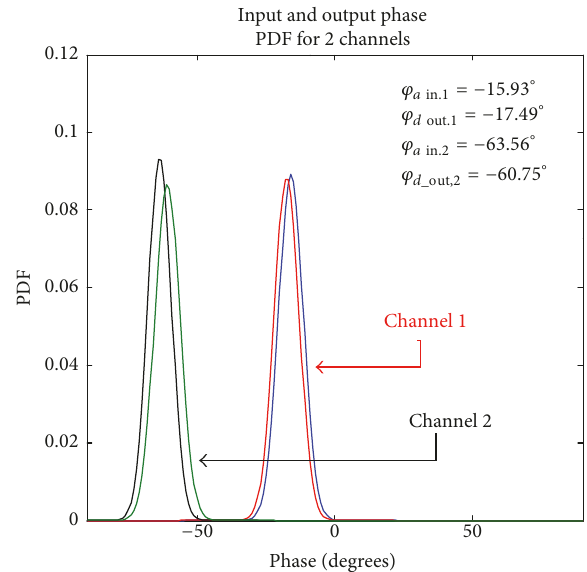
Figure 8: Phase distribution of decoded data of 2 channels used for quantifying the performance of